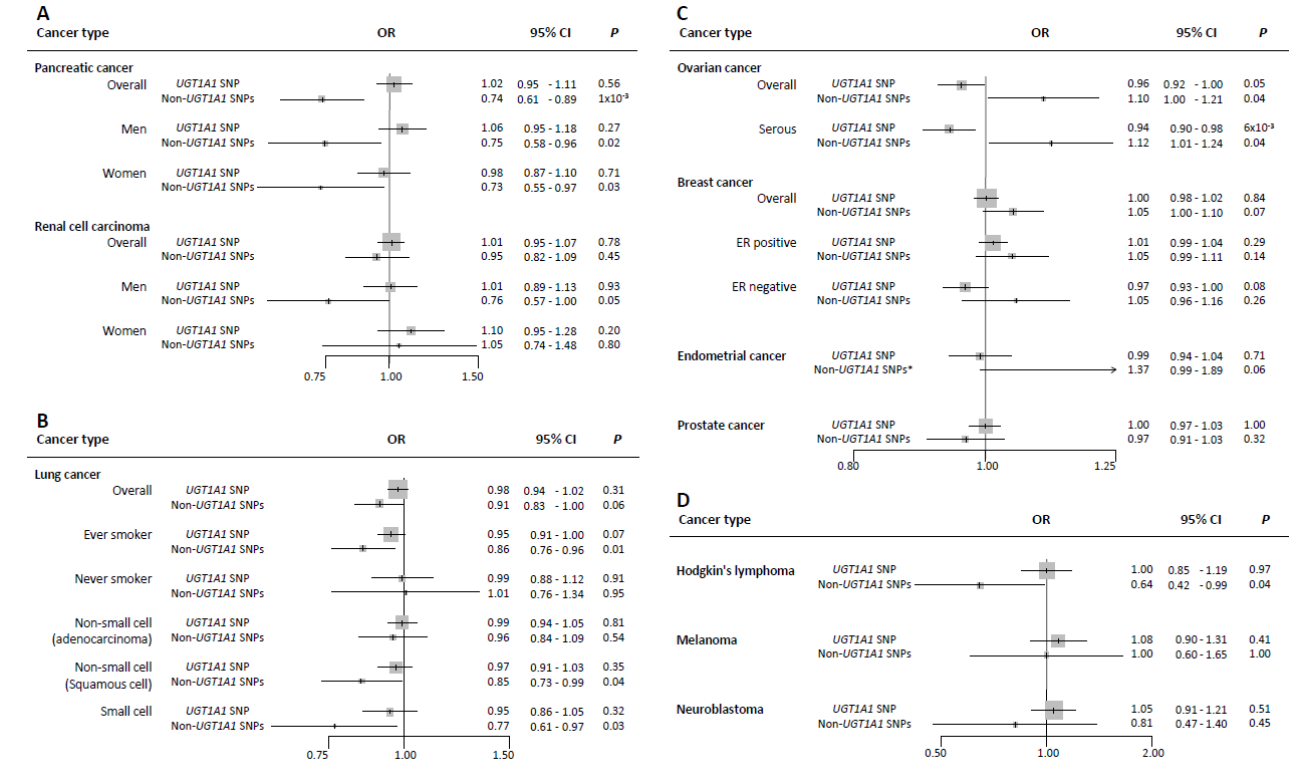
Figure 1. Forest plot of associations between genetically-predicted bilirubin levels and risk of ten cancers (per one-standard deviation (1-SD) increment in circulating total bilirubin levels equivalent to ≈ 4.4 µ mol/L). ( A ): The association between 1-SD increment in bilirubin levels predicted by UGT1A1 SNP and the non- UGT1A1 SNPs with risks of pancreatic cancer and renal cell carcinoma (overall, men, and women). ( B ): The association between 1-SD increment in bilirubin levels predicted by UGT1A1 SNP and the non- UGT1A1 SNPs with risk of lung cancer (overall, ever smoker, never smoker, adenocarcinoma, squamous cell, and small cell lung cancers. ( C ): The association between 1-SD increment in bilirubin levels predicted by UGT1A1 SNP and the non- UGT1A1 SNPs with risks of ovarian cancer (overall and serous), breast cancer (overall, ER positive, and ER negative), endometrial cancer, and prostate cancer. ( D ): The association between 1-SD increment in bilirubin levels predicted by UGT1A1 SNP and the non- UGT1A1 SNPs with risks of Hodgkin’s lymphoma, melanoma, and neuroblastoma. The results are provided by a likelihood-based MR test, * with the exception of endometrial cancer, which results are provided by the Egger-MR test. Abbreviations: OR odds ratio, CI confidence interval, p p -value, ER estrogen